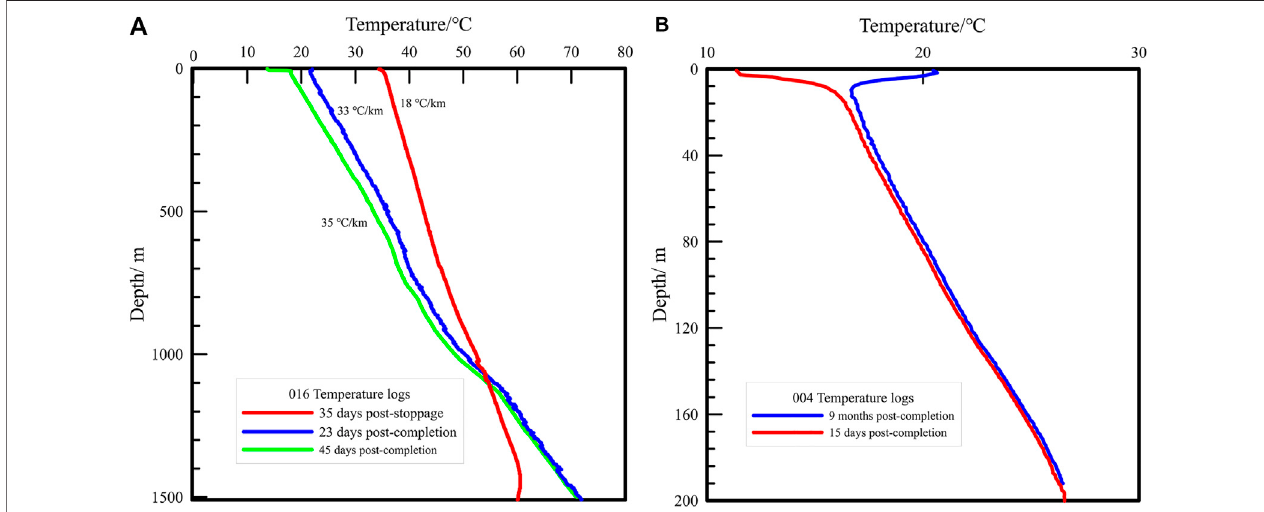
FIGURE 2 | The difference between unsteady temperature measurement and steady-state temperature